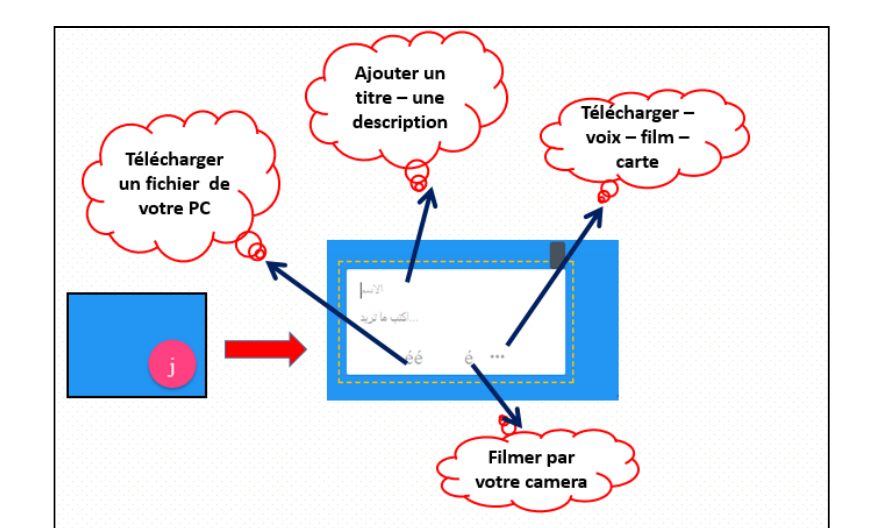
Fig. 10. Padlet outil de travail à distance et de partage des ressources